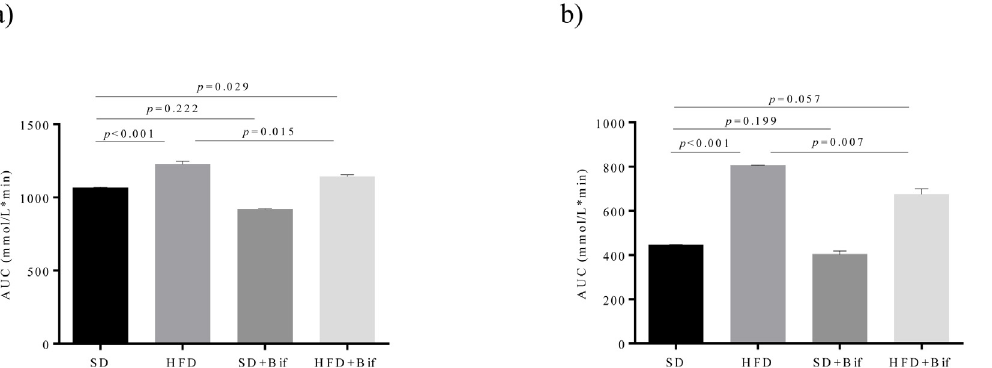
Fig 1. Oral glucose tolerance (a) and insulin sensitivity (b) in different mouse groups after 14 weeks of dietary intervention. SD group: control mice receiving a standard diet (SD) plus placebo; HFD group: obese mice receiving a high-fat diet (HFD) plus placebo; SD+Bif group: control mice receiving SD and a daily dose of 1 x 10 9 CFU B . pseudocatenulatum CECT 7765; HFD+Bif group: obese mice receiving HFD and a daily dose of 1 x 10 9 CFU B . pseudocatenulatum CECT 7765 by gavage during 14 weeks (n = 10). Data are expressed as means of area under curve (AUC) from the plots of glucose concentration (mmol/L) versus time (min) (standard errors in bars). Statistically significant differences were determined by ANOVA with Bonferroni ’ s post hoc test a p <